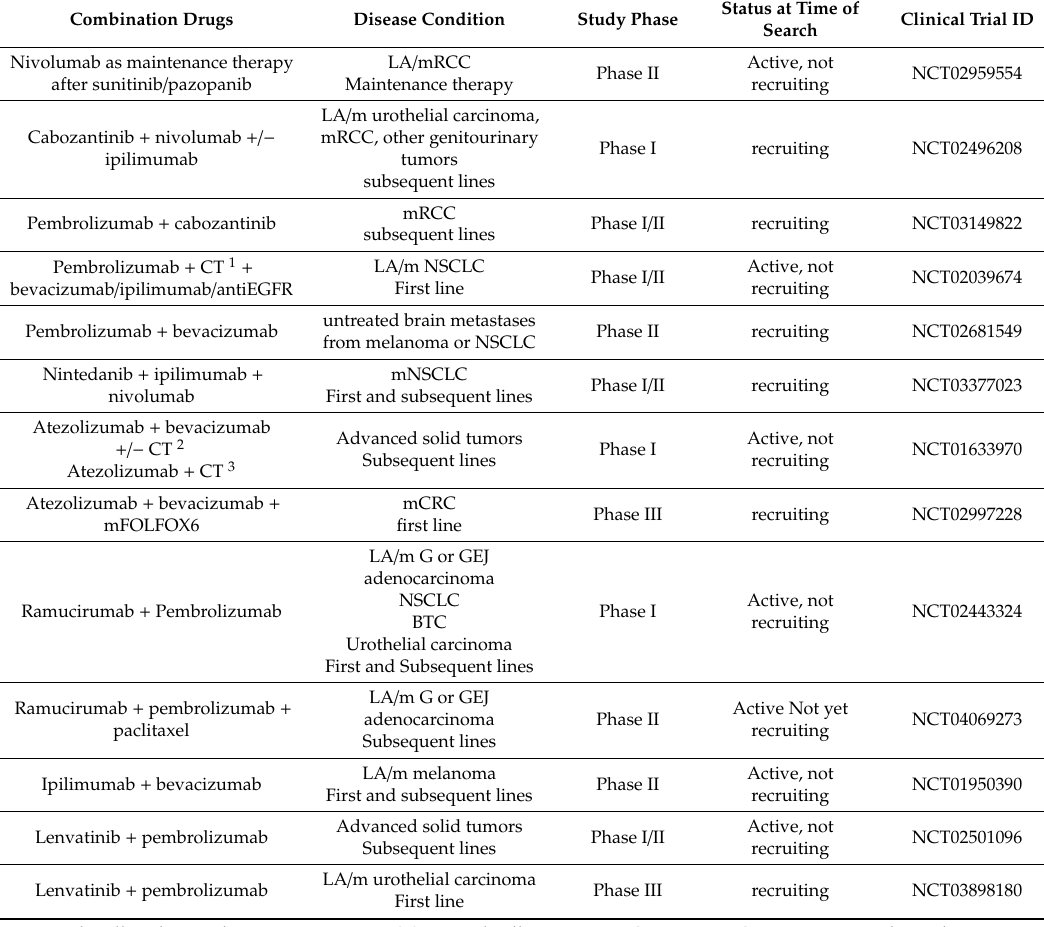
Table 2. Ongoing